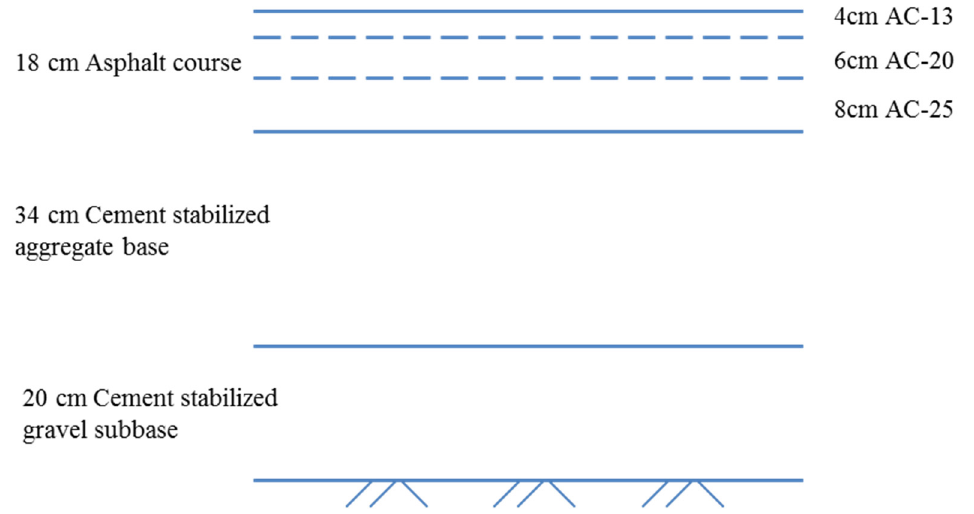
Figure 3. Schematic diagram of the asphalt pavement structure.